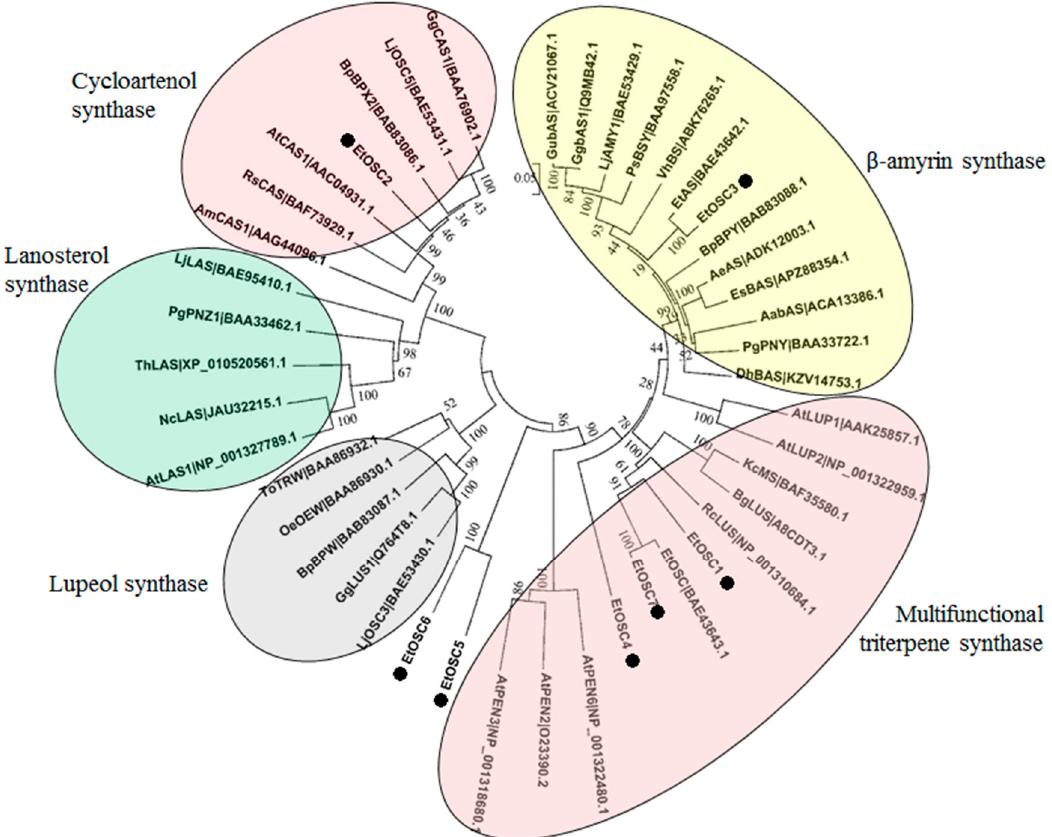
Figure 5. Phylogenetic analysis of the putative OSCs identified in the E. tirucalli transcriptome. The OSCs protein sequences were aligned by ClustalX software and the phylogenetic tree was constructed by the neighbor-joining method using MEGA ver. 5.0 software with 1000 bootstraps. In the figure: